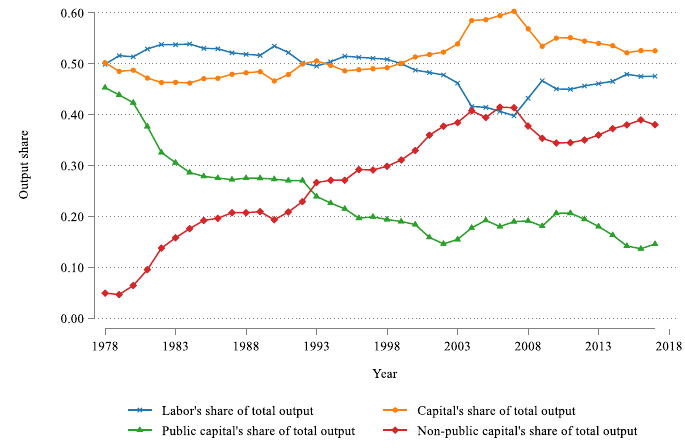
Figure 5. Share of total output.